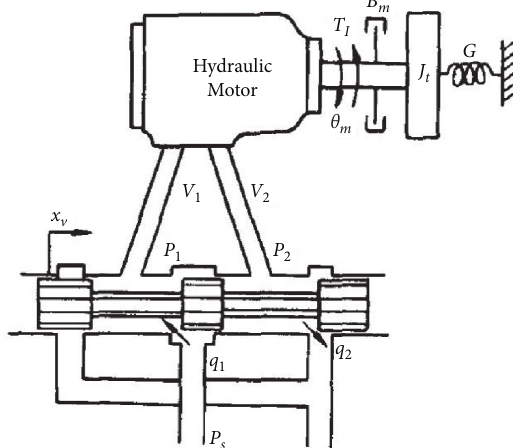
Figure 1: Model of the valve controlled hydraulic motor